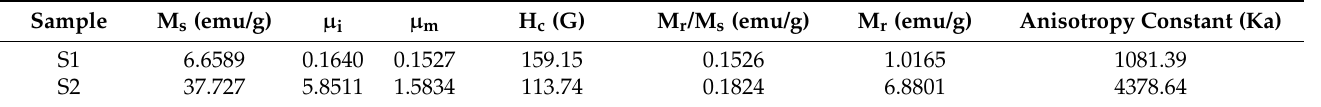
Figure 6 . M–H curves at room temperature for S1 and S2 samples. Table 3. The magnetic properties of the S1 and S2